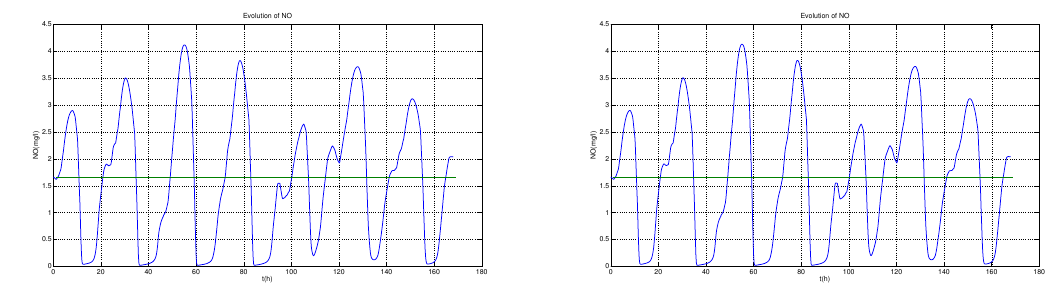
Figure 7. Evolution of S NO : (left) case1; (right) case 2.